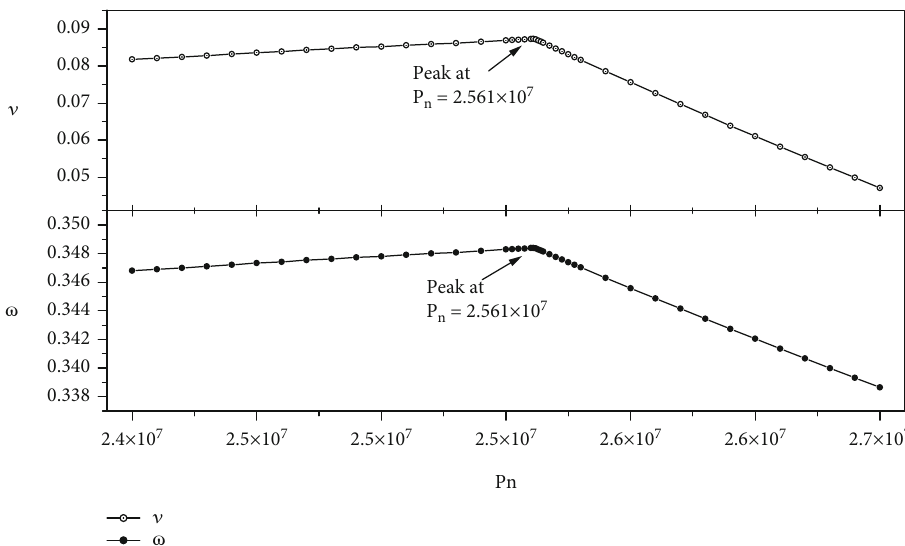
Figure 9: (a) The relation between the accumulated prime numbers and the inverse χ 2 parameter ν from 24 million to 27 million primes with small steps. (b) The relation between the accumulated prime numbers and the Brody parameter ω from 24 million to 27 million primes with small steps.